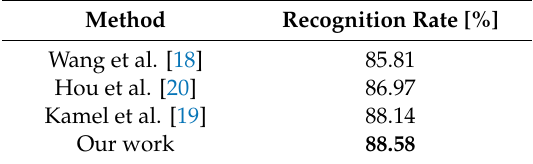
Table 4. Comparison of the recognition rates for the UTD-MHAD set and LOSO eight-fold